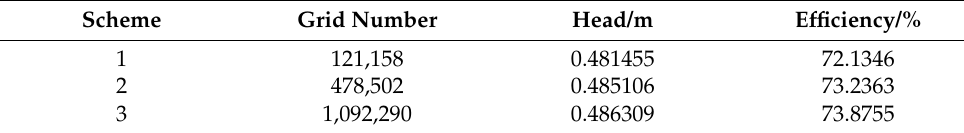
Figure 3. Hexahedral mesh. Table 1. Verification of grid independence.